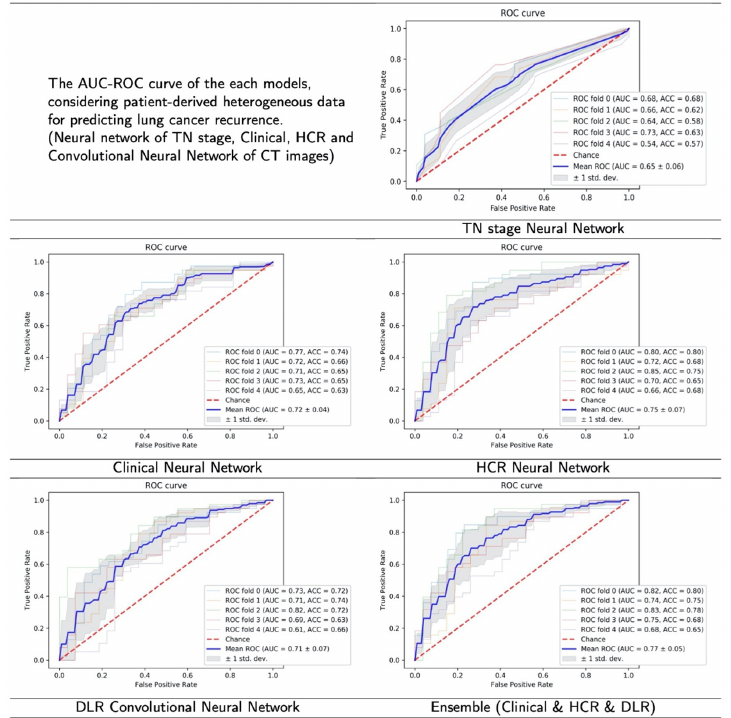
Figure 4. The result figures of ROC curve with AUC value. The highest average AUC value was recorded in the proposed model (ensemble), followed by HCR, Clinical, DLR and TN stage.